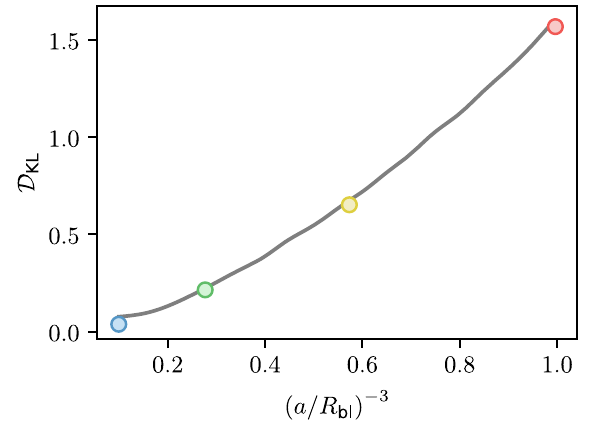
FIG. 10. Scaling of the disorder strength as a function of density. The Kullback-Leibler divergence D increases mono- KL − 3 . This quantifies the additional correla- tonically with ð a=R bl Þ tions induced by the Rydberg blockade effect. The dots indicate the Kullback-Leibler divergence corresponding to the specific simulations presented in Fig. 6.